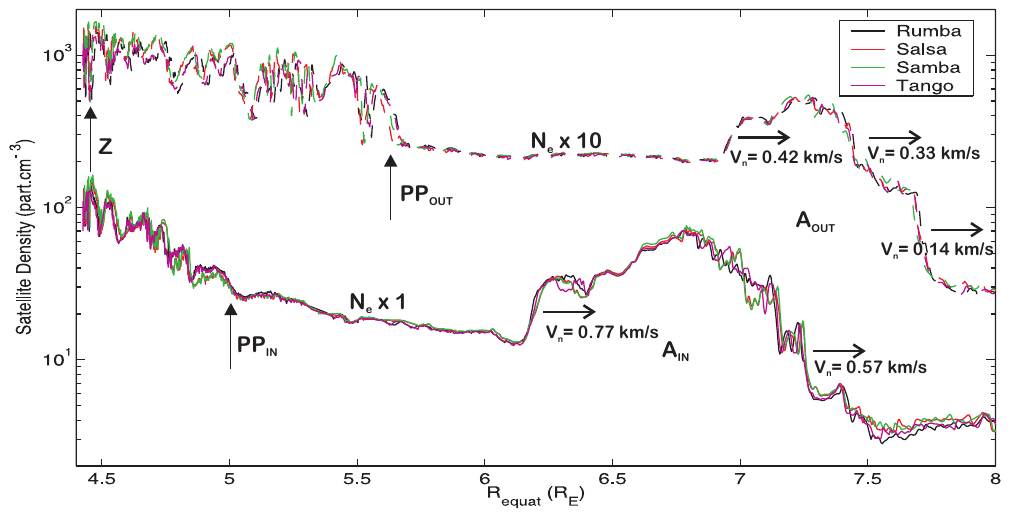
Fig. 3. The plasmapause/plume crossings of the Cluster constellation, adapted from Darrouzet et al. (2004). The densities for an inbound and an outbound are shown with a factor-of-10 shift in the upper traces. The labeled speeds of the moving structures were derived from the timing